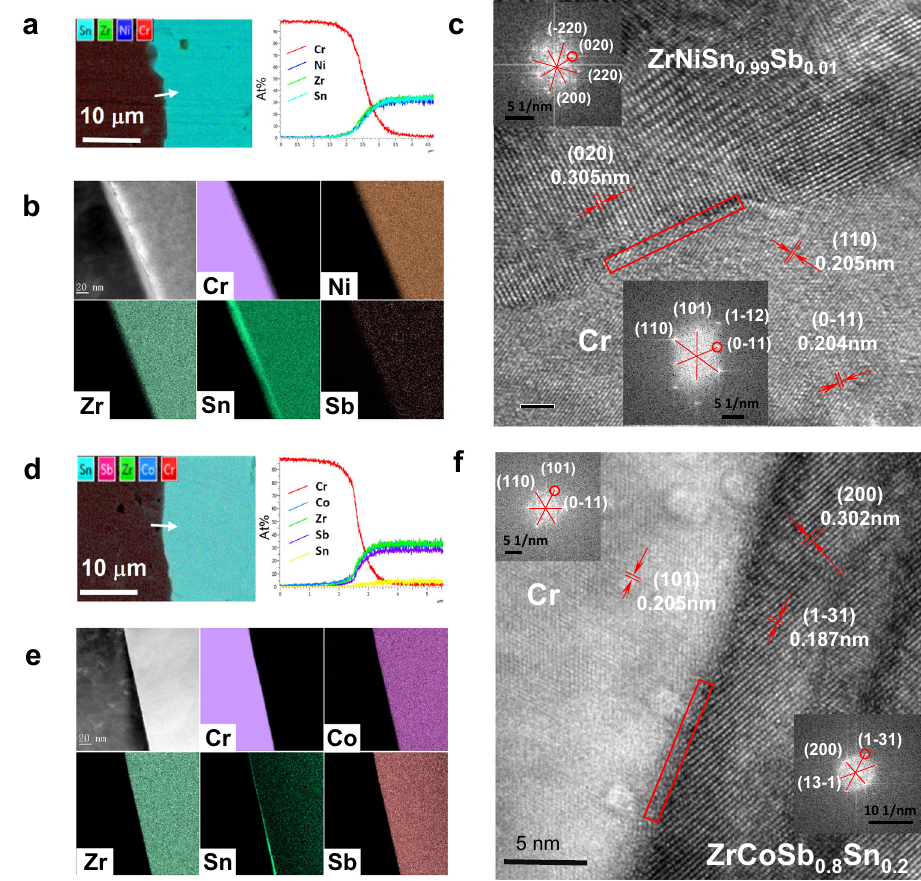
Fig. 3|Microstructuresofbondinginterface. Microstructuresof as-prepared Cr/ ZrNiSn 0.99 Sb 0.01 and Cr/ZrCoSb 0.8 Sn 0.2 joints: a Elemental mapping and composi- tion pro fi les along the arrow-line in SEM. b High-angle annular dark- fi eld (HAADF) image and the corresponding EDS elemental mapping. c High-resolution TEM to show the interface matching between Cr and ZrNiSn 0.99 Sb 0.01 phases, insets: Fourier transformation images corresponding to Cr and ZrNiSn 0.99 Sb 0.01 ,